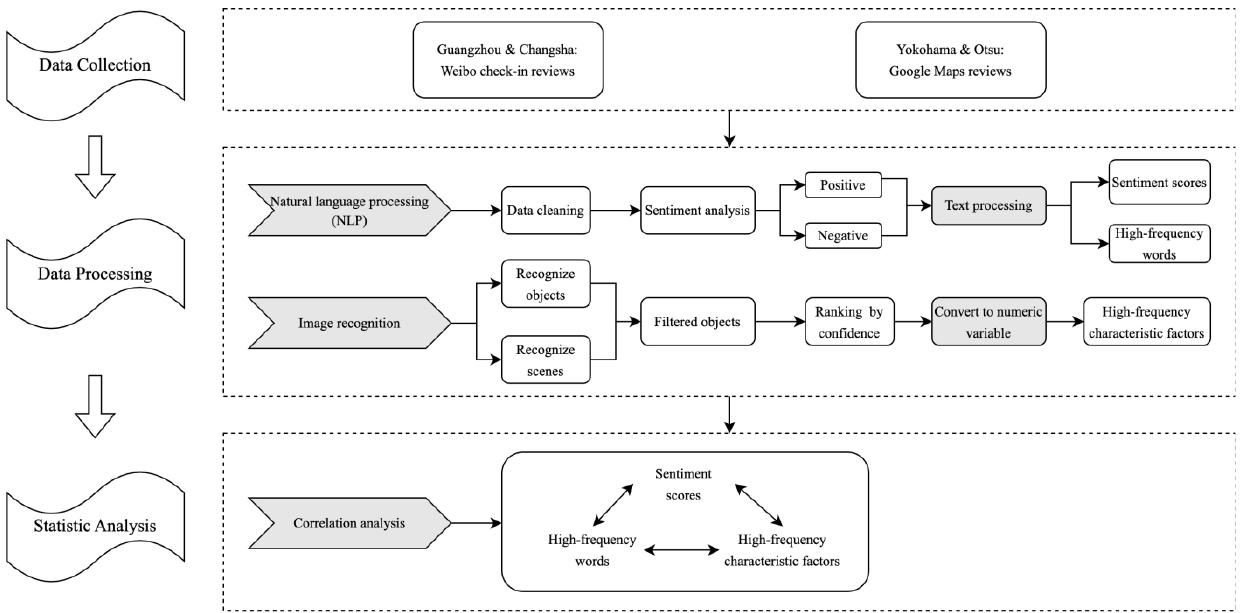
Figure 1. The technical framework.